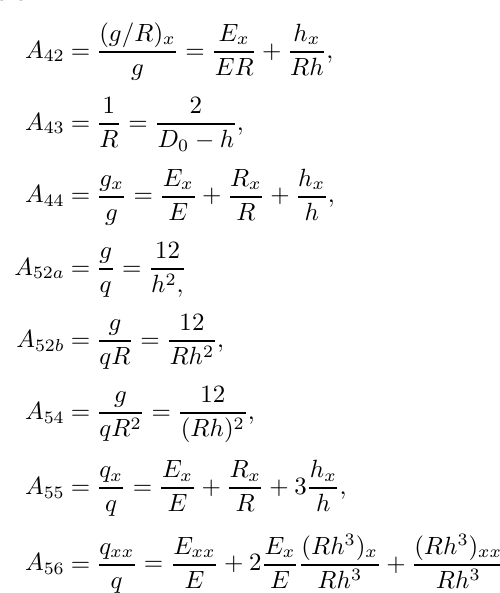
Fig. 9. Frequency response of linearly tapered FGM shells: (dash) uniform thickness, (dot) same slope, (solid) opposite slope.